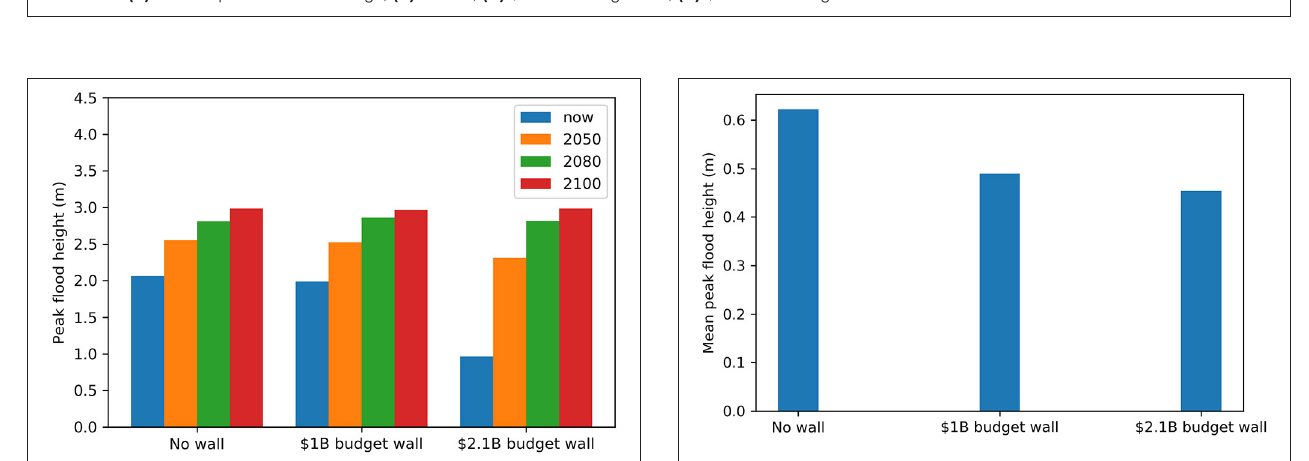
FIGURE 11 | Selected point in Lower Manhattan (denoted by 1) where peak flood heights are calculated for Hurricane Sandy and various different seawalls, using G EO C LAW . (A) NYC map with no storm surge, (B) no wall, (C) $1 billion budget wall, (D) $2.1 billion budget wall.